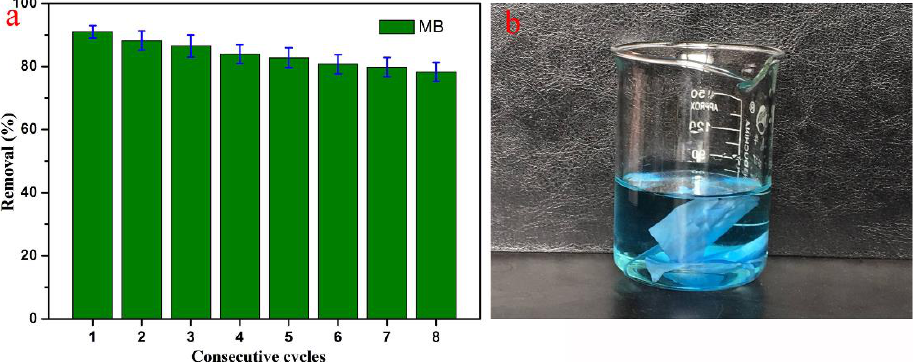
Figure 10. Relative adsorption reutilization studies towards removal of MB for different consecutive cycles at room temperature of PCL/(50%)PCD composites ( a ) and the photograph of PCL/(50%)PCD composite after eight reutilization cycles ( b ).